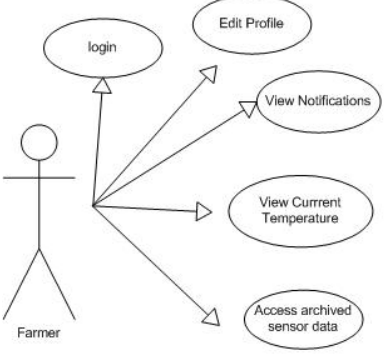
Fig. 8. Farmer and Web Application Use